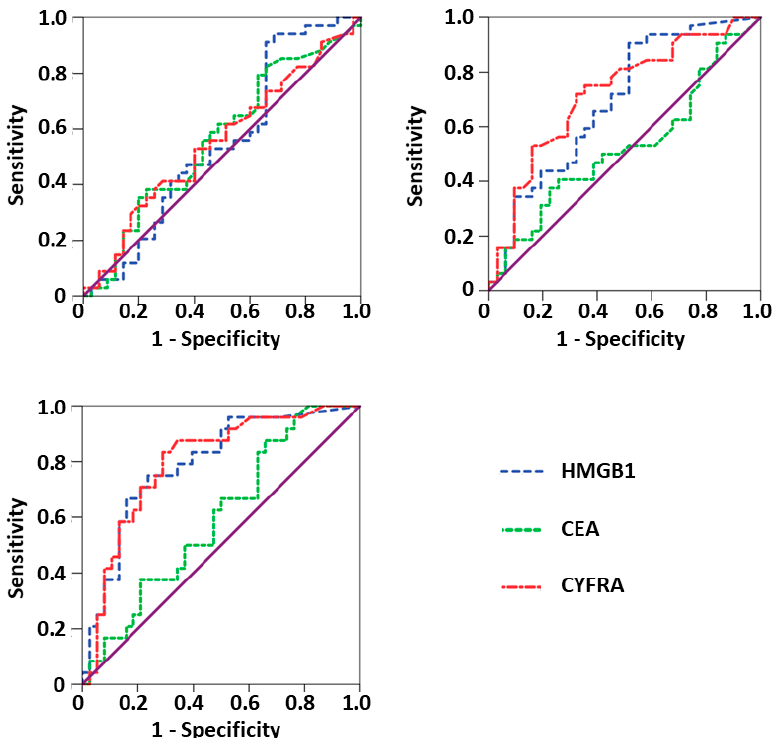
Figure 2. Receiver Operating Characteristic (ROC) curves for prediction / detection of progressive disease of non-small-cell lung carcinoma (NSCLC) patients calculated for high mobility group box 1 protein (HMGB1), carcinoembryonic antigen (CEA ) and cytokeratin 19-fragments (CYFRA 21-1) in NSCLC patients a) before start of therapy (upper part left), b) prior to the second chemotherapy cycle (upper part right), and c) prior to the third chemotherapy cycle (lower part left).